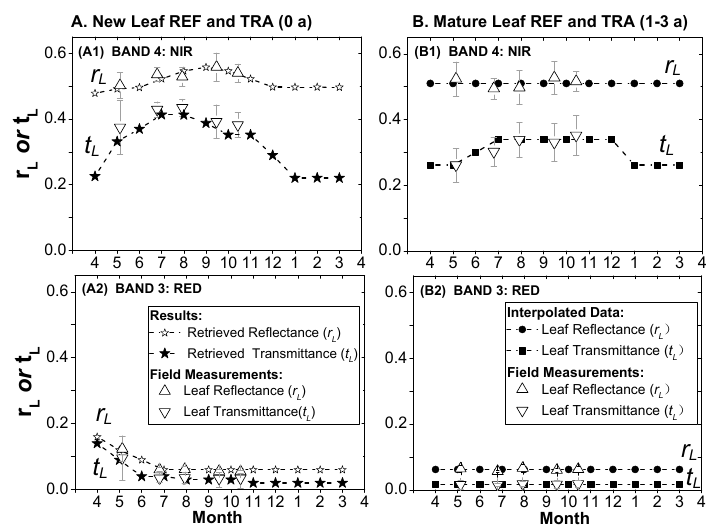
Figure 10. Validation of estimated new leaf LOPs in the NIR band ( A1 ) and red band ( A2 ) and the constructed mature leaf LOPs trajectories ( B1 , B2 ).